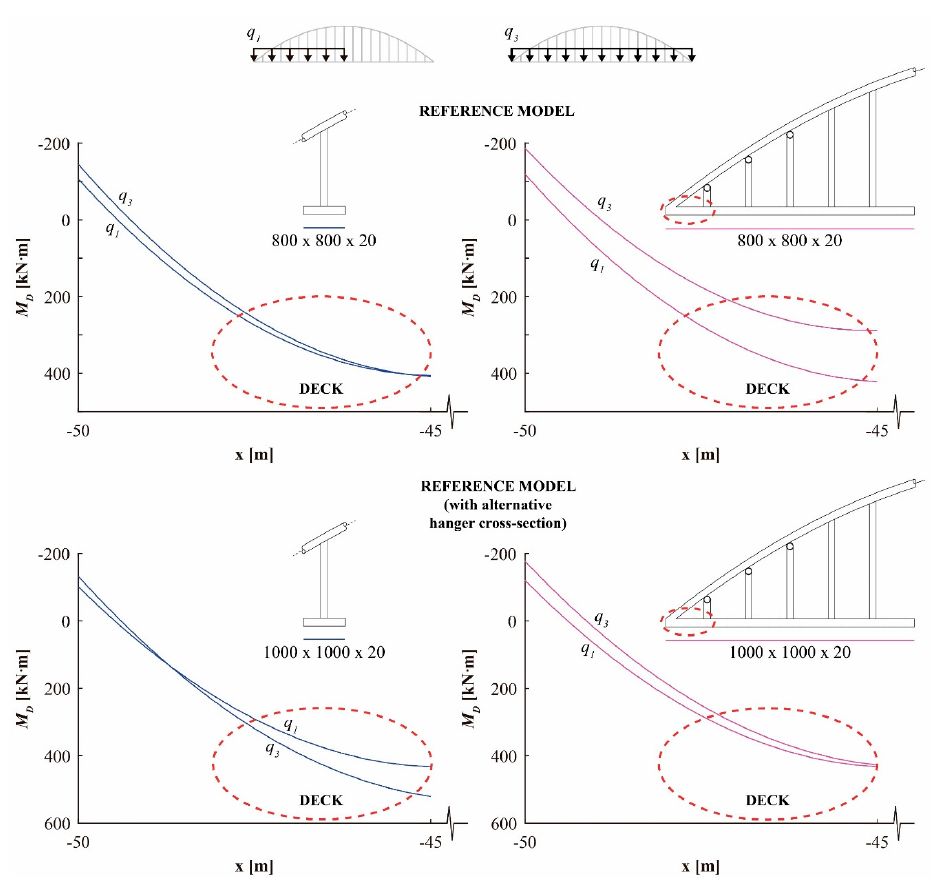
Figure 15. Effect of mixed fixed-pinned hangers on the reduction of bending moments under q 3 .